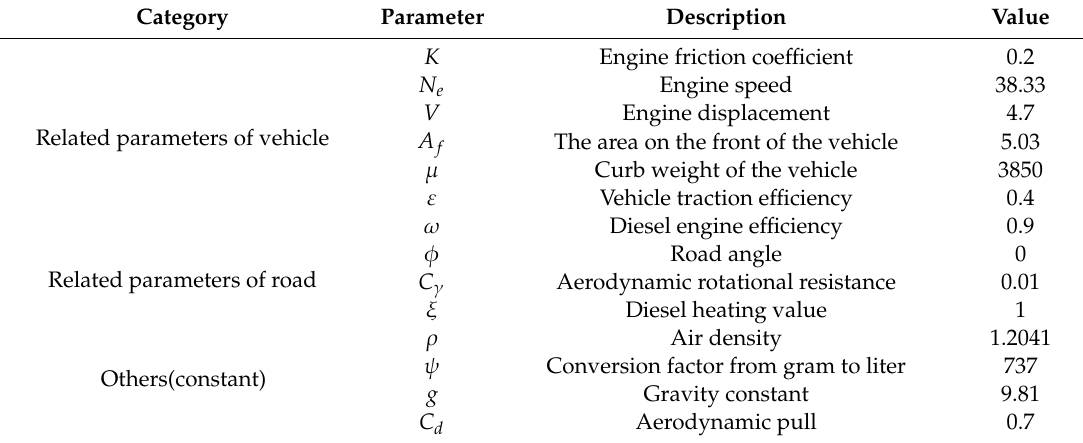
Table 1. The comprehensive modal emissions model (CMEM)